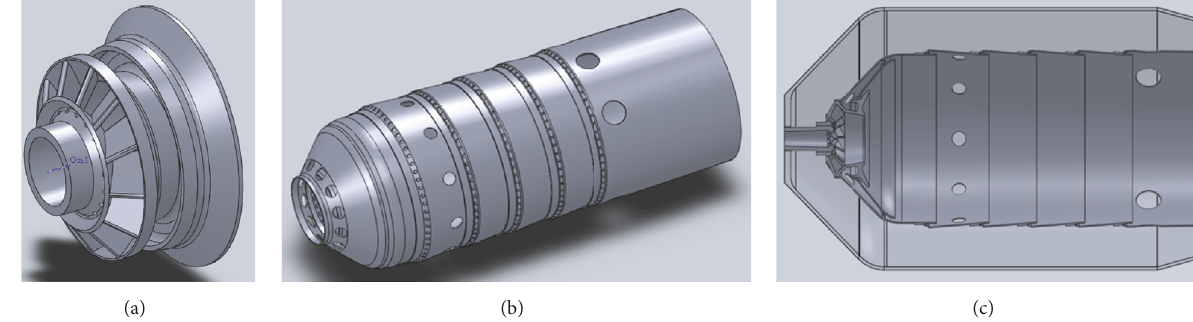
Figure 4: Geometry model of the combustor: (a) swirler; (b) combustion liner; (c) longitudinal section of the combustor.